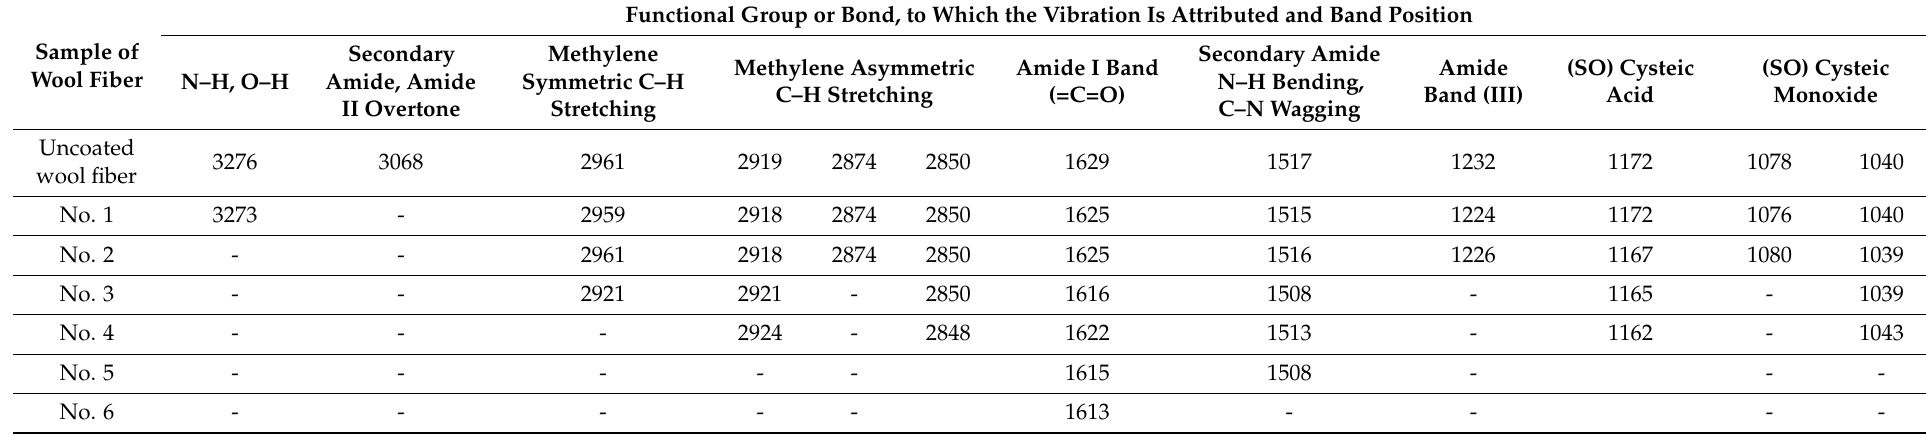
Table 5. The characteristics of functional groups bands in FTIR of wool fibers and wool fibers with coatings of Cu x